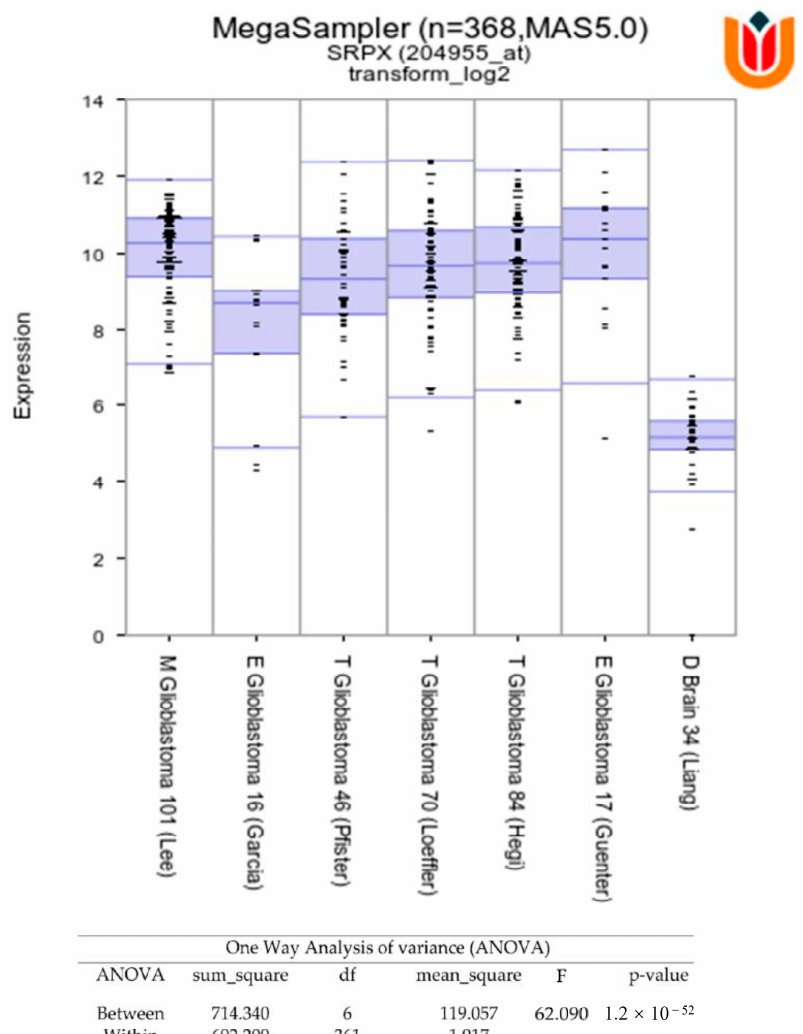
Figure 3. SRPX is overexpressed in glioblastoma tumor tissues. SRPX (ID 8006) expression in glioblastoma tumors ( n = 334). R2 database was used to perform the analysis.